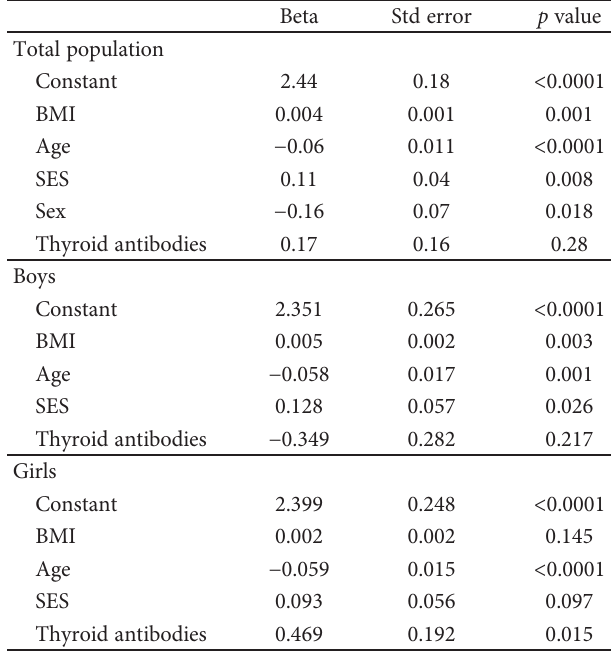
Table 4: Multivariate regression analysis with TSH as a dependent